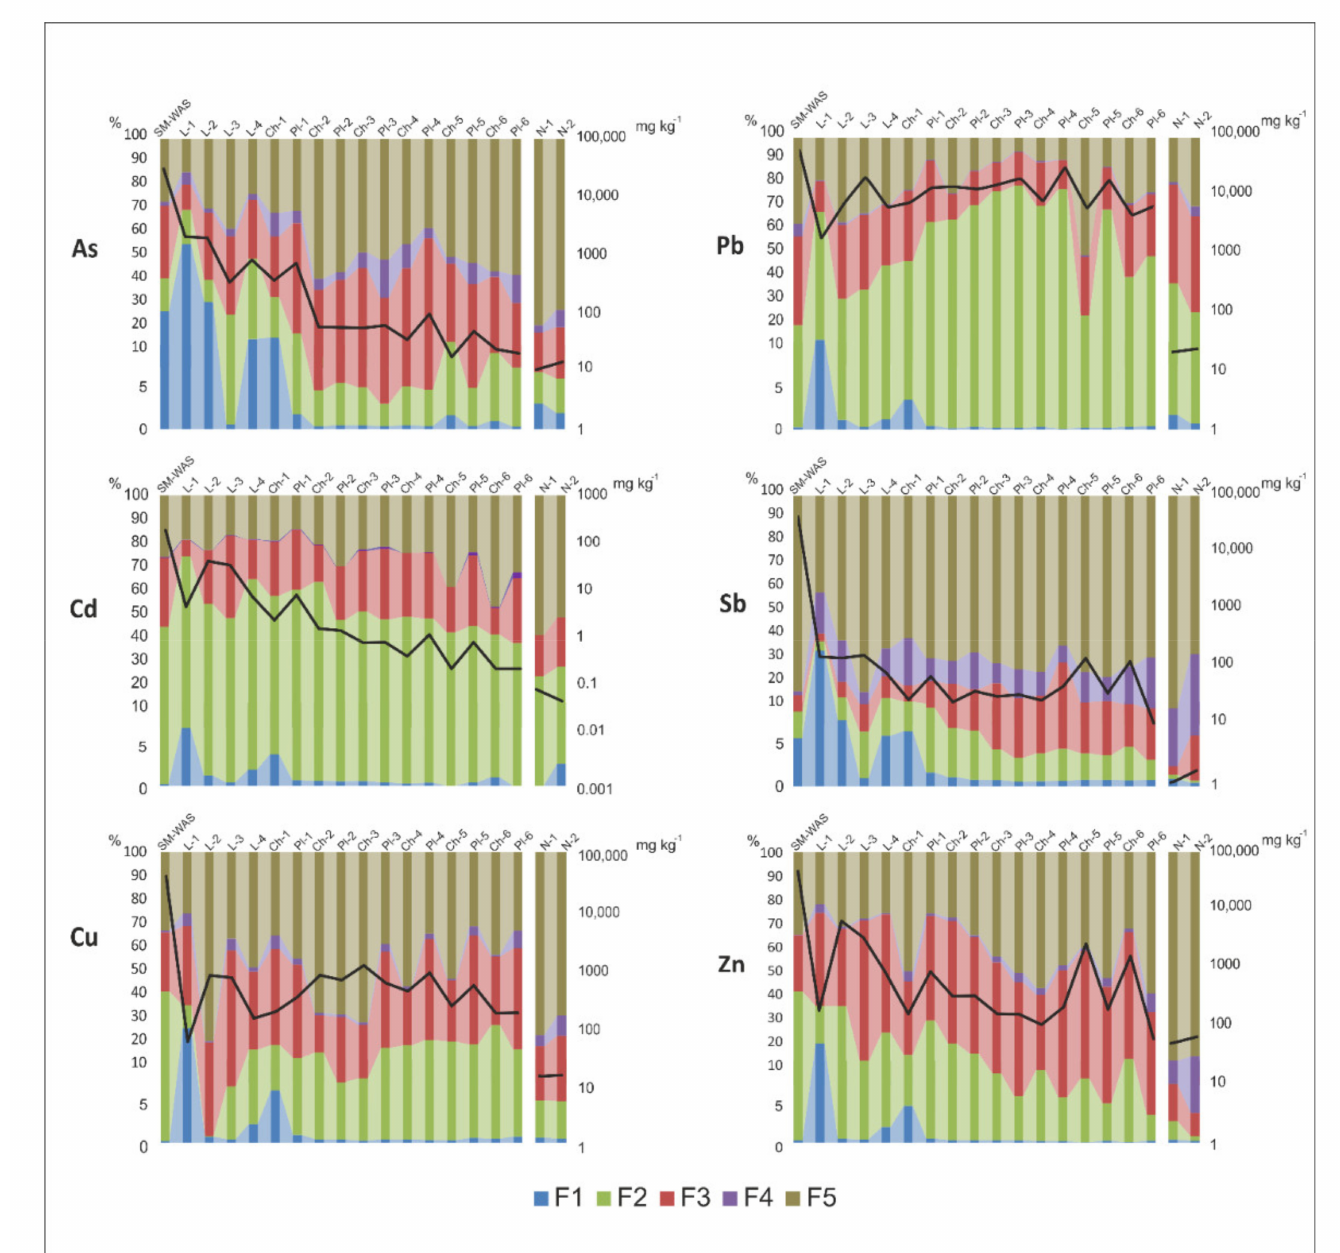
Figure 5. Graph showing the total (black line, in mg kg − 1 ) and fractional (F1, F2, F3, F4 and F5, in %) contents of As, Cd, Cu, Pb, Sb and Zn at the different sampling